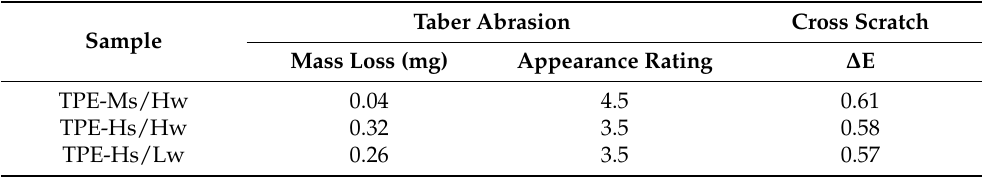
Table 6. Abrasion resistance of TPE prepared by SEBS with various styrene content.